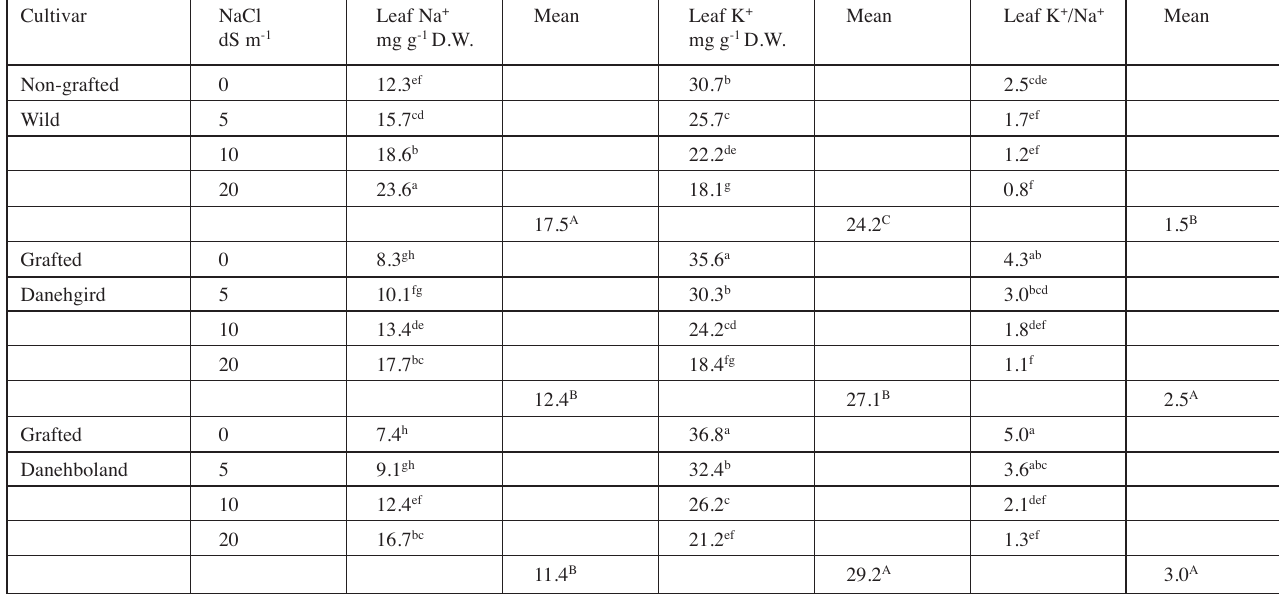
Tab. 6: Sodium chloride effect on leaf Na + , K + (mg g -1 D.W.) and K + /Na + ratio of non-grafted wild, grafted ‘Danehgird’ and ‘Danehboland’ cultivars of Z. spina-christi. Cultivar